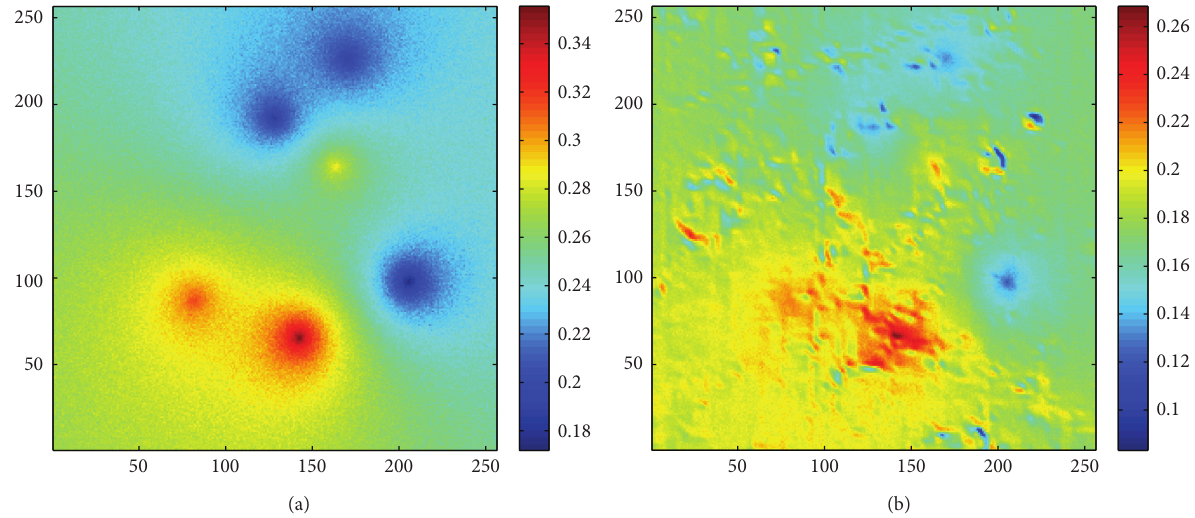
Figure 16: Simulation results of the location based distribution of the minerals (sample rate = 1000, size: 256×256 ). (a) the reflectance of the distribution of the samples; (b) final result of the terrain with diffusion.